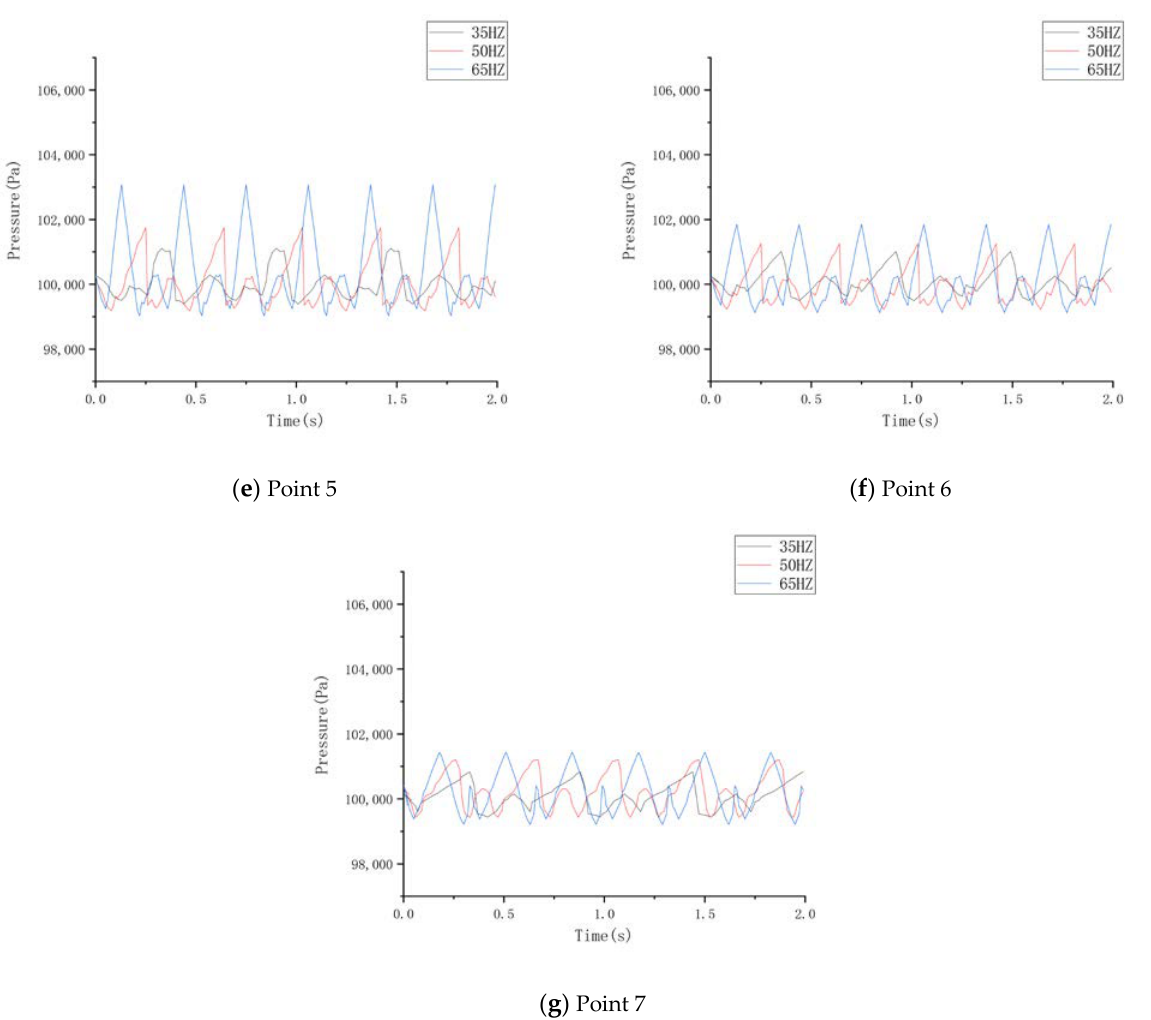
Figure 17. Pressure pulsation of the monitoring point under different speeds when the outlet pressure is 0.1 MPa.